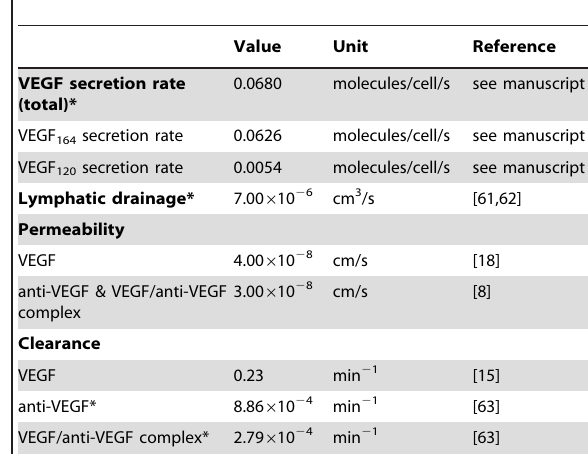
Table 4. Transport